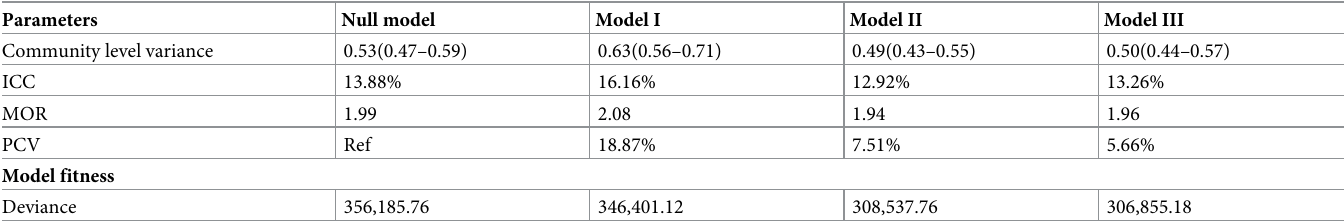
Table 3. Model comparison and random effect analysis